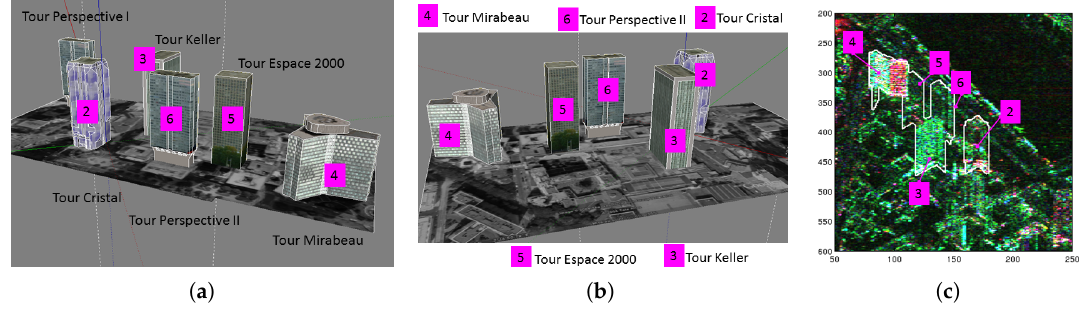
Figure 11. The buildings analyzed using a dedicated 3D modeling ( a ) The ground Truth with the buildings as seens as the sensor; ( b ) The Ground Truth with the far side of the buildings; ( c ) Polarimetric images of the considered